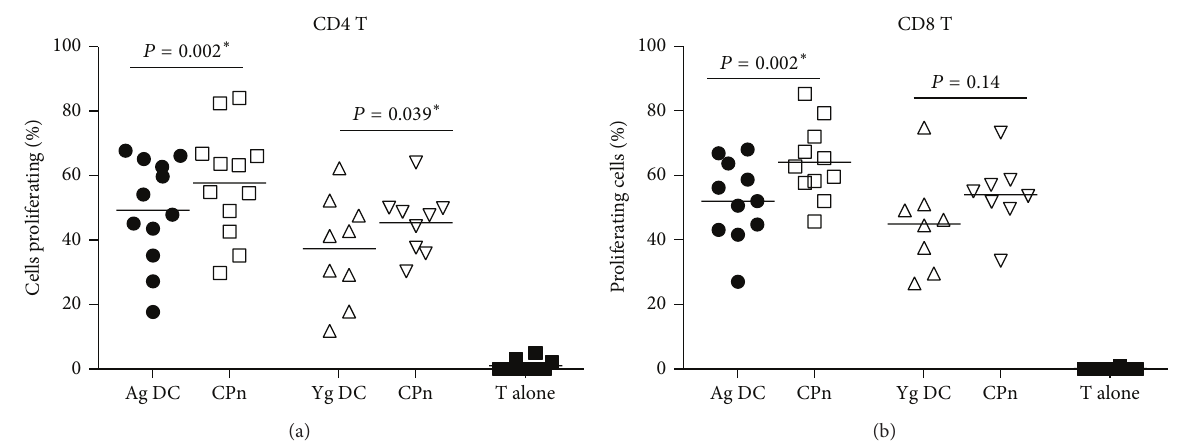
Figure 4: Enhanced proliferation of CD4 and CD8 T cells by CPn-stimulated DCs from aged subjects in an allogeneic DC-T cell coculture. CPn-stimulated and CPn-unstimulated DCs from aged and young subjects were cultured with allogeneic, CFSE labeled T cells from young subjects for 6 days. Graphs depict the proliferation of (a) CD4 T cells; (b) CD8 T cells as determined by flow cytometry. Each dot corresponds to a separate subject. Data is of 12 aged and 9 young subjects for (a) and 11 aged and 8 young for (b). 𝑃 value depicted is comparison of CPn-stimulated DCs with unstimulated DCs for both aged and young subjects.